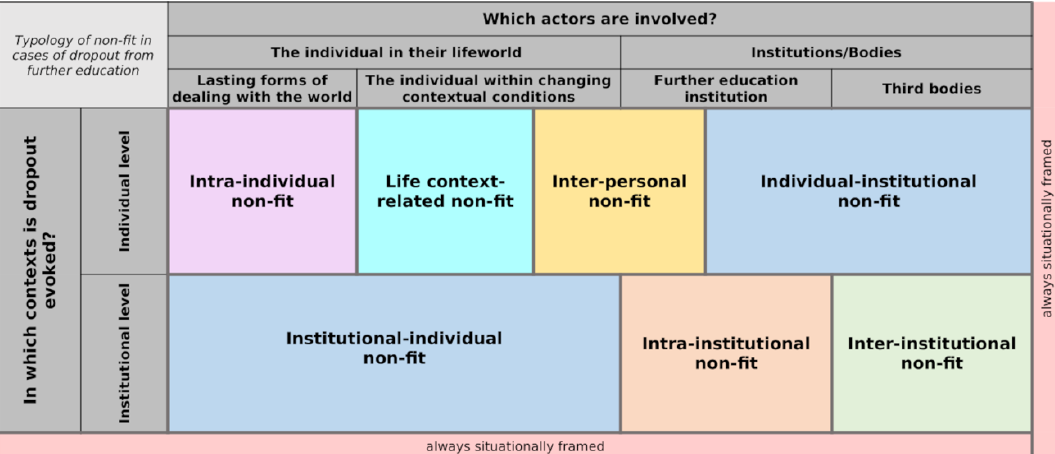
Figure 1 : Typology of non-fit in cases of dropout from adult